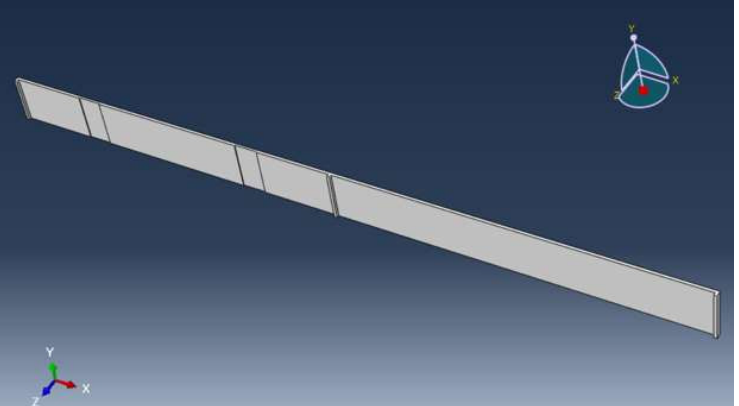
Figure 21. Model graph after the creation of damage and support.